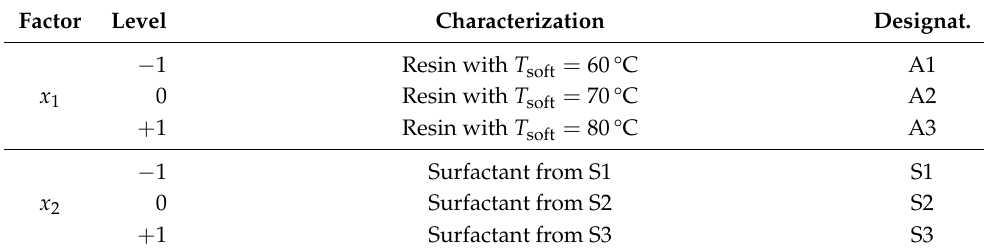
Table 4. Levels and codes of primary